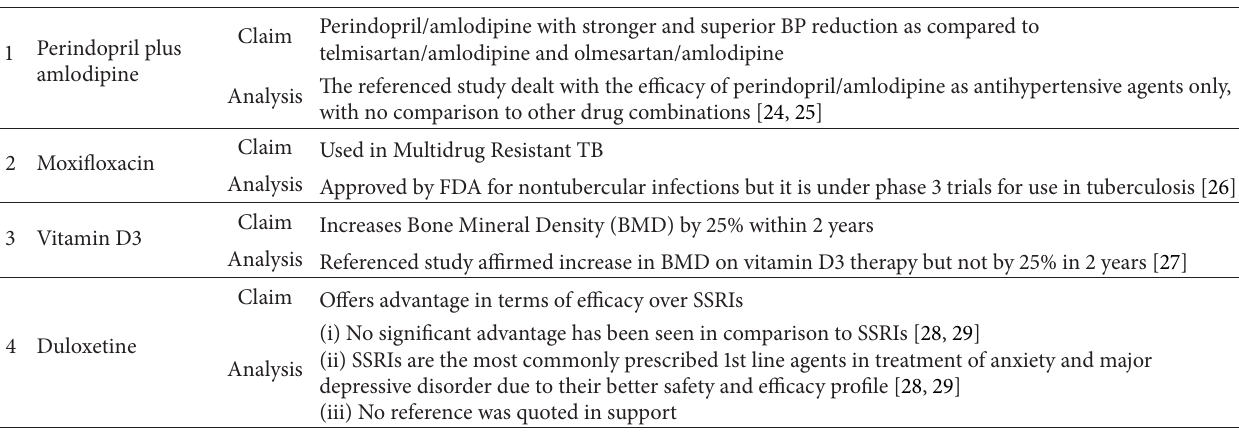
Table 3: Examples of exaggerated claims in drug